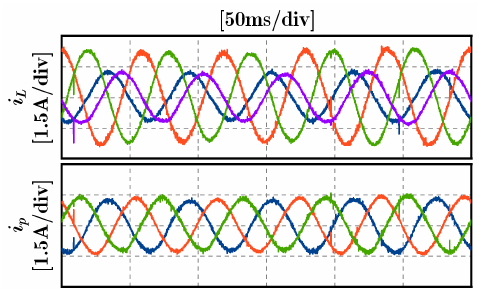
Figure 16. Phase current reconstruction under 200 r/min.